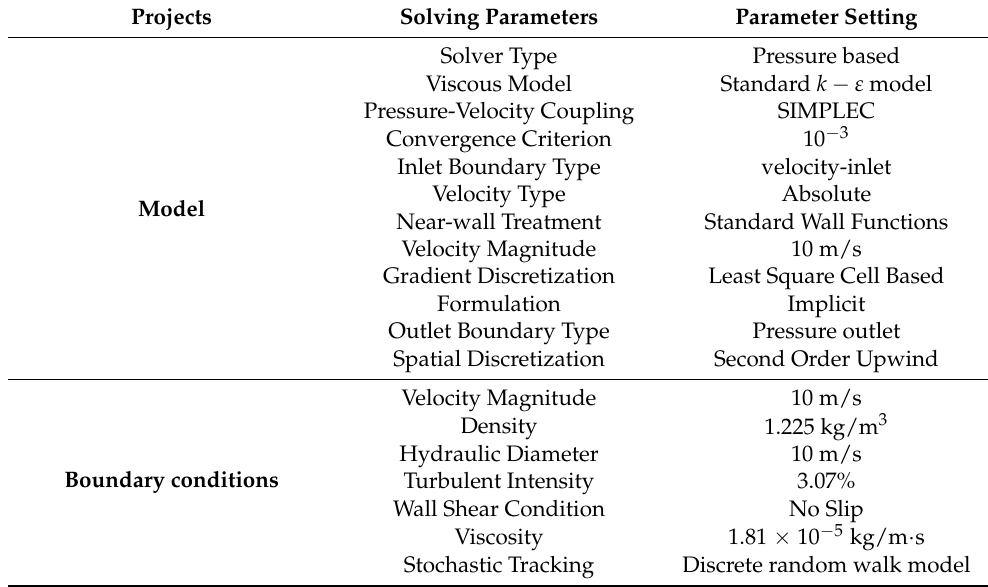
Table 2. Boundary conditions.